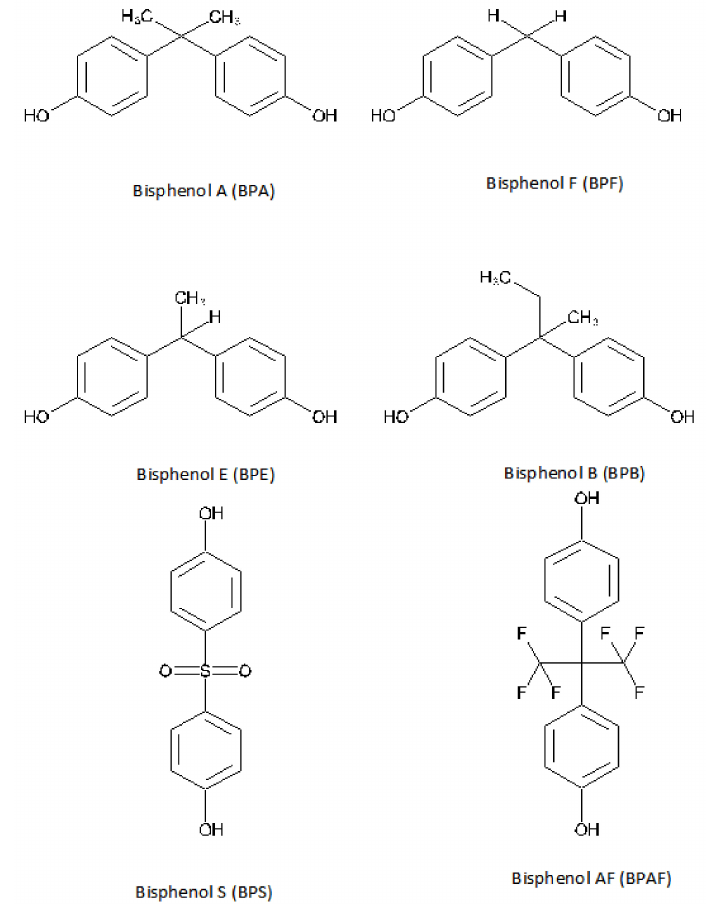
Figure 1. Bisphenols with endocrine-disrupting activity. Prepared by author based on Gallart-Ayala et al., 2011